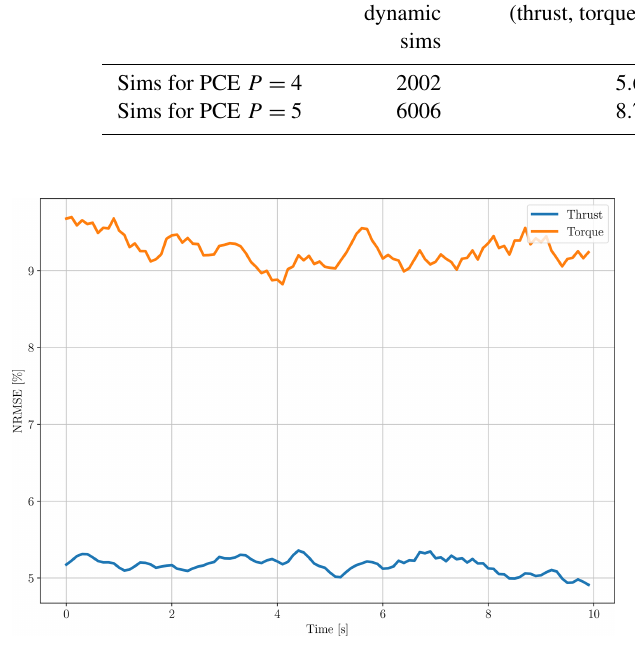
Figure 7. Surrogate model P = 4 NRMSEs for both thrust and torque with respect to the reference